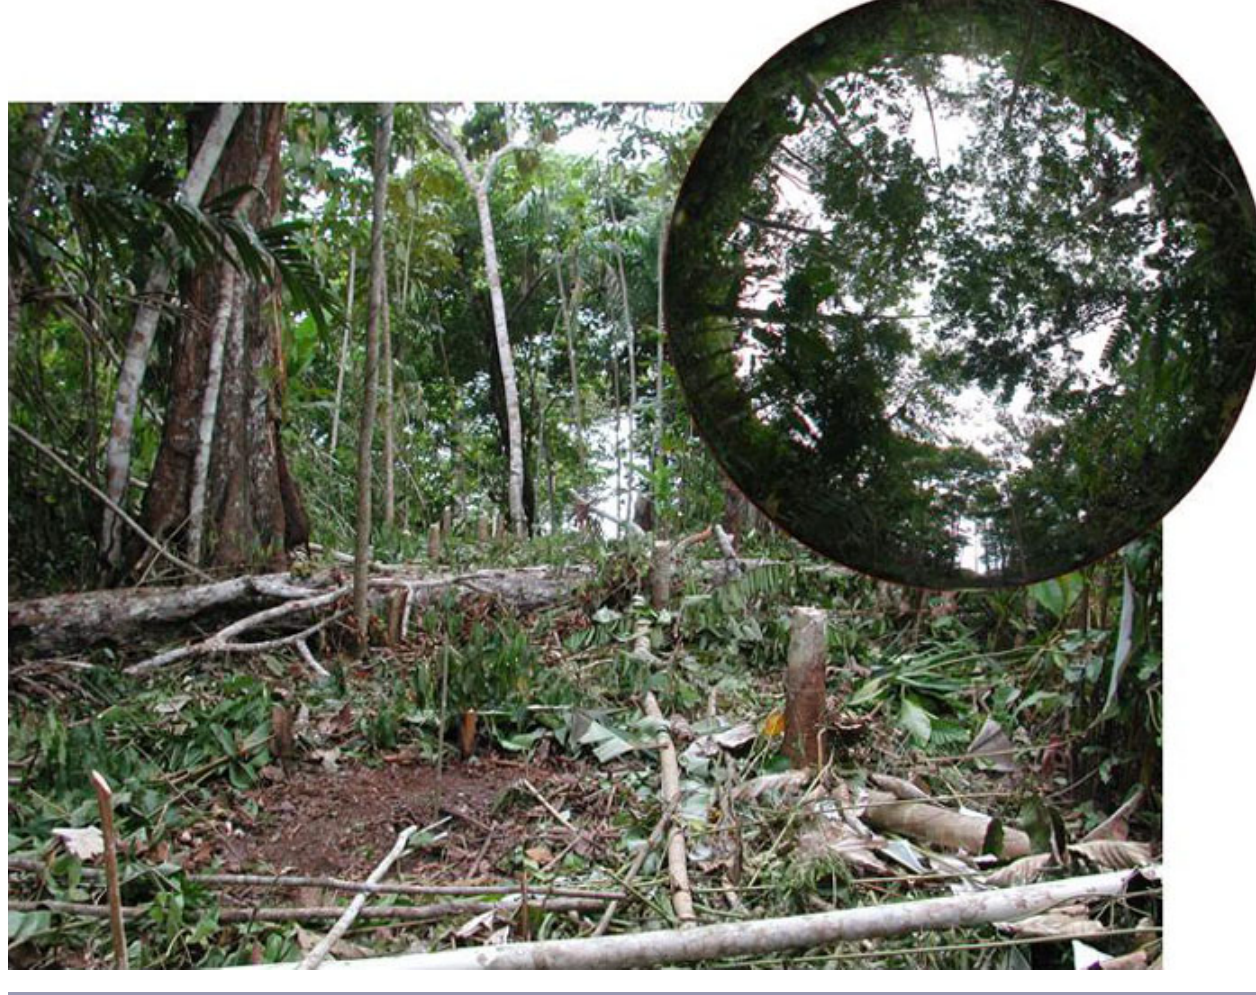
Fig. 2. First enrichment-planting project in Ipetí (September 2005). The old fallow (secondary forest) is managed using the traditional strip-planting method. A 6-m strip is shown. Hemispherical inset (3-m strip) gives a sense of the vertical structure that is